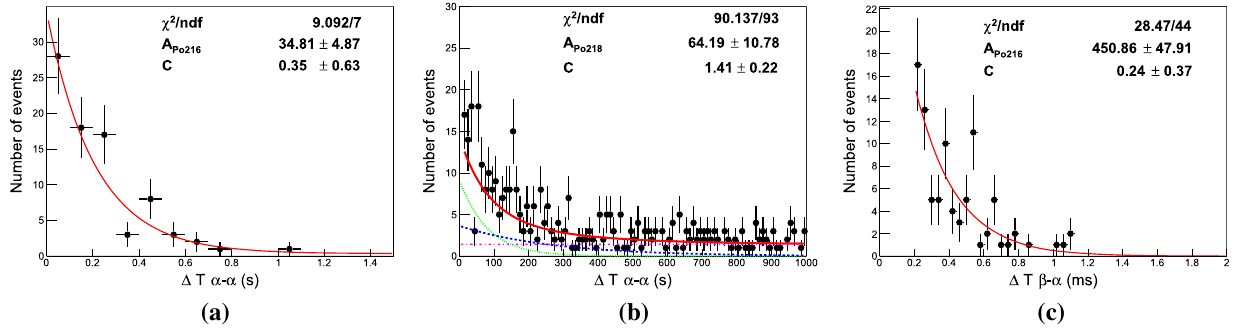
216 Po measurement in ( a ), and 222 Rn → 218 Po (blue-dashed line, half- life 186 s) together with random coincidence events (purple-dashed- dotted line), in the NaI-034 crystal; ( c ) Δ T between successive β and α events from 214 Bi → 214 Po (half-life 0.164 ms) in the NaI-036 crystal are shown. Due to dead time of the data acquisition system, events with Δ T less than 0.2 ms were not